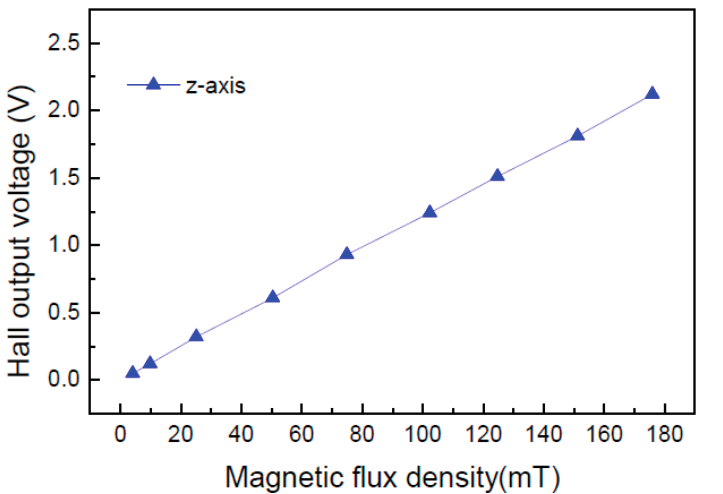
Figure 13. Hall output voltage of the integrated Hall sensor versus magnetic flux density.